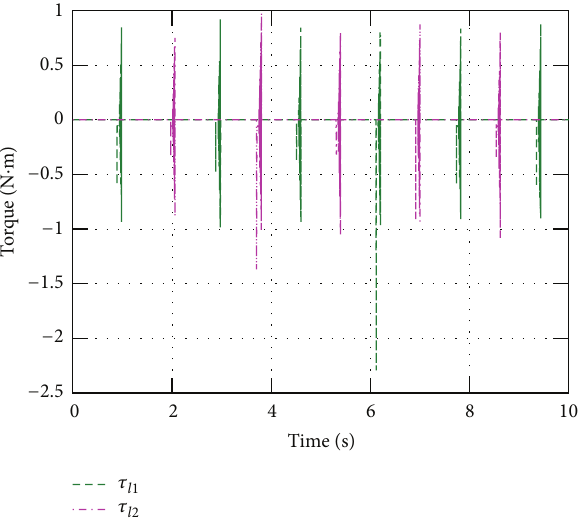
Figure 10: Joint torque values with energy compensation control ( 𝜏 𝑙𝑗 : leg 𝑗 ). The negative joint torque values are supplied to the legs immediately before the quadruped robot switches the supporting leg.